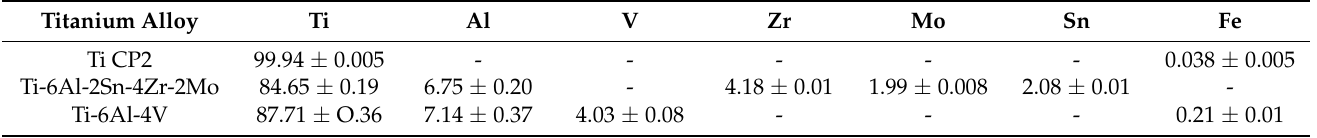
Table 1. Chemical Composition of the used Titanium alloys (wt.